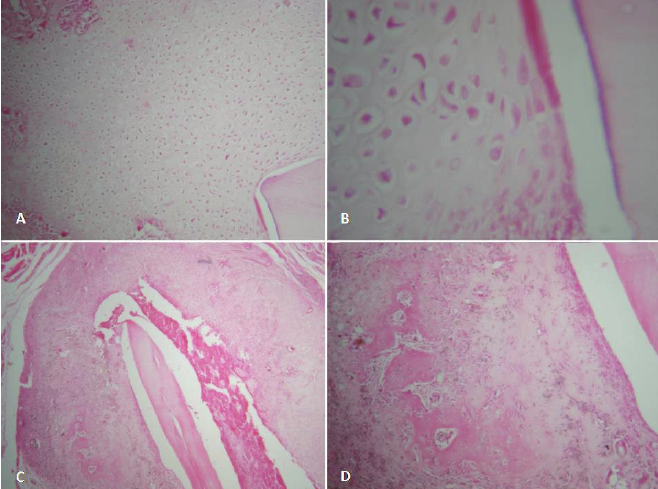
FIGURE 1 – A : Bone repair of the fracture showing cartilage formation in the control group at 21 days (HE 100x); B : Close-up of the cartilage formation (HE 400x); C : Fragment of the fractured bone envolved by a bone callous in development with granules of the material inserted in the experimental group after 21 days (HE 40x); D : Close-up of the bone formation parallel to the fractured bone (HE 100x).